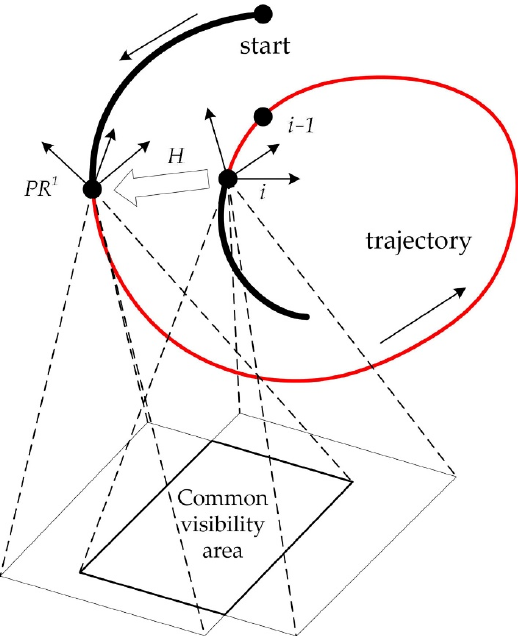
Figure 4. Referencing AUV to 𝑃𝑅 (cid:2869) . Calculation transformation H from CS pos i to CS 𝑃𝑅 (cid:2869)